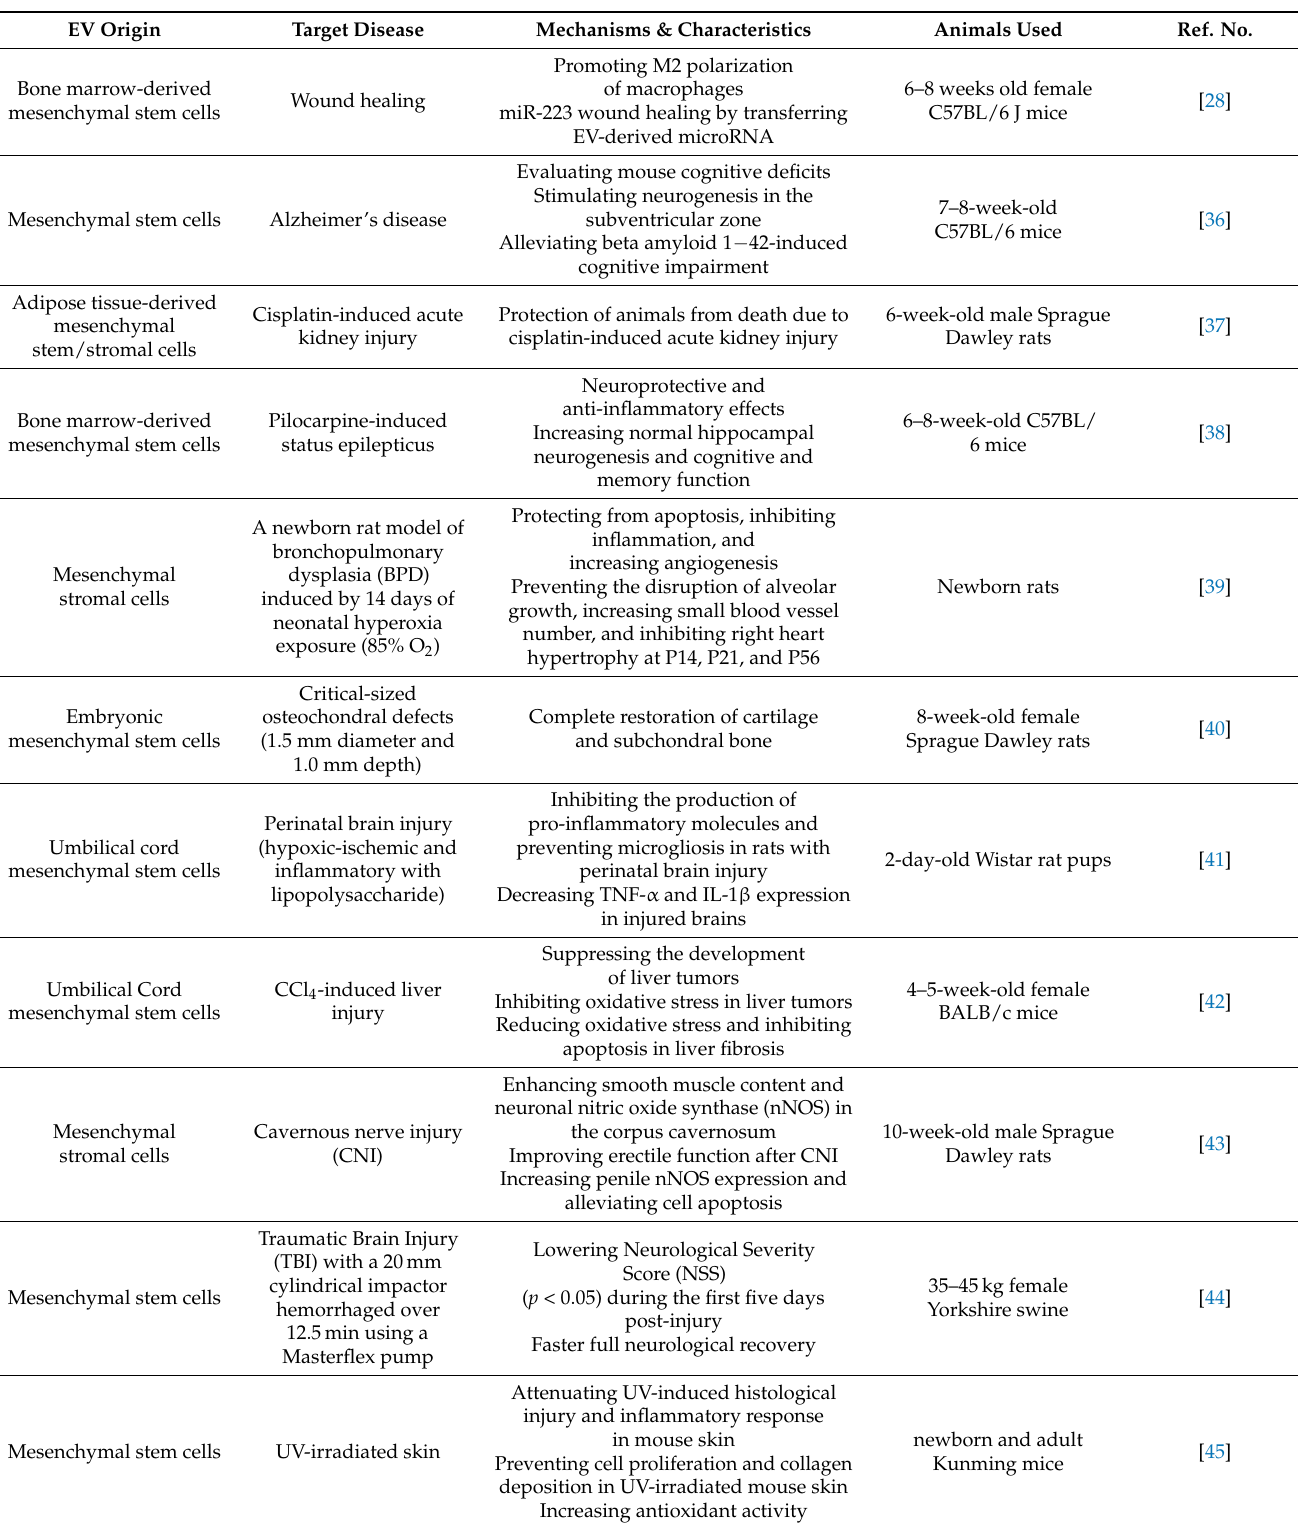
Table 1. MSC-derived EVs of different origins with different effects in various